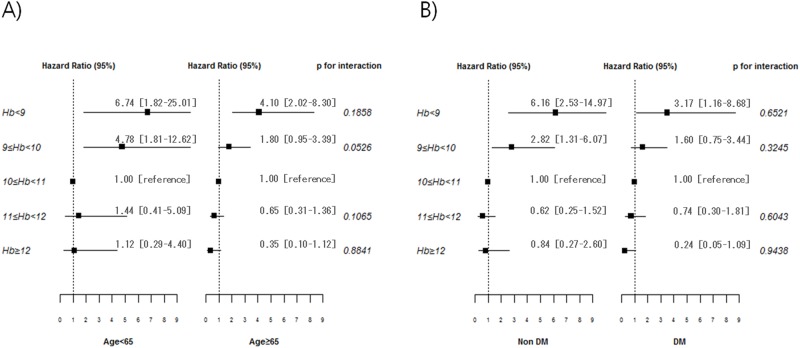
Hazard ratios of mortality based on time-dependent Hb level according to the age group (A) and diabetes status (B).Multivariate analysis used covariates as follows: age, sex, dialysis vintage, diabetes, cardiovascular disease, albumin, and high-sensitivity C-reactive protein, erythropoiesis-stimulating agent (ESA) dose, ferritin, and transferrin saturation (TSAT). HR, hazard ratio; CI, confidence interval